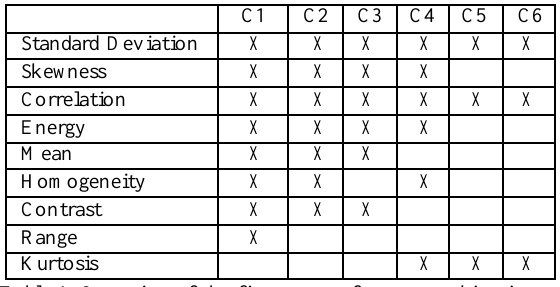
Table 1: Overview of the five texture feature combinations (C1- C6) used during the